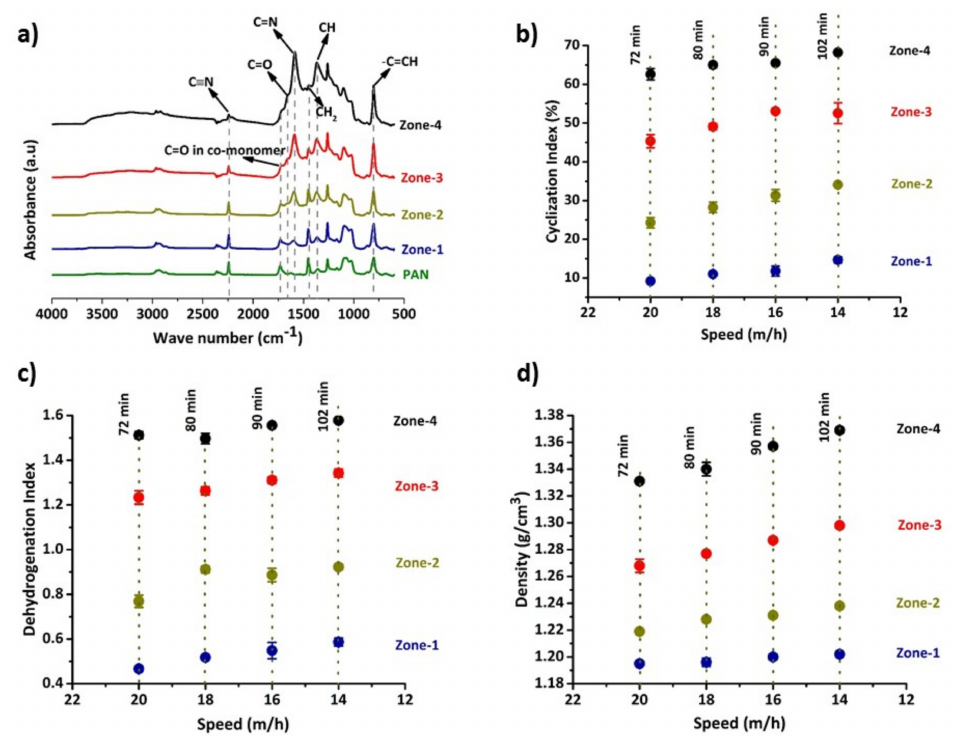
Figure 2. Chemical structure and physical property variations in fibres ( a ) an example FTIR spectra of fibres from each zone of stabilization stage of CF-102 sample, ( b ) variation of cyclization index, ( c ) dehydrogenation index variation, and ( d ) density of samples at each stage with respect to process conditions. Note: Total time taken for stabilization at each speed is represented by vertical dotted